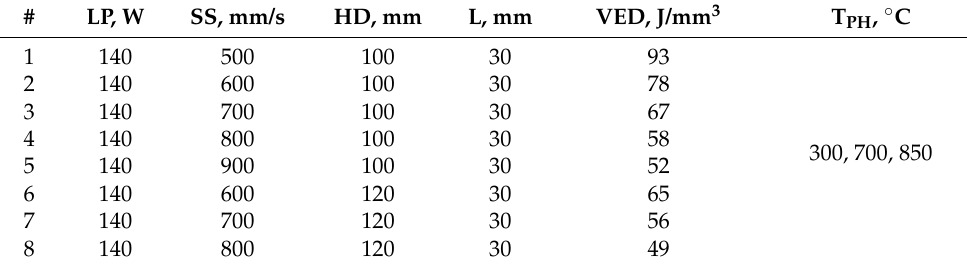
Table 2. The process parameters used for manufacturing of the